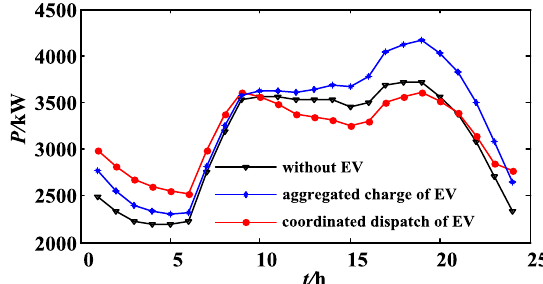
Fig. 7 Load curves under two regulation modes of EV